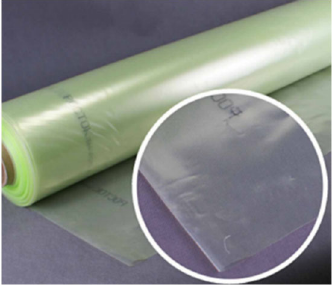
Figure 2. Foreign inclusions on the sleeve.